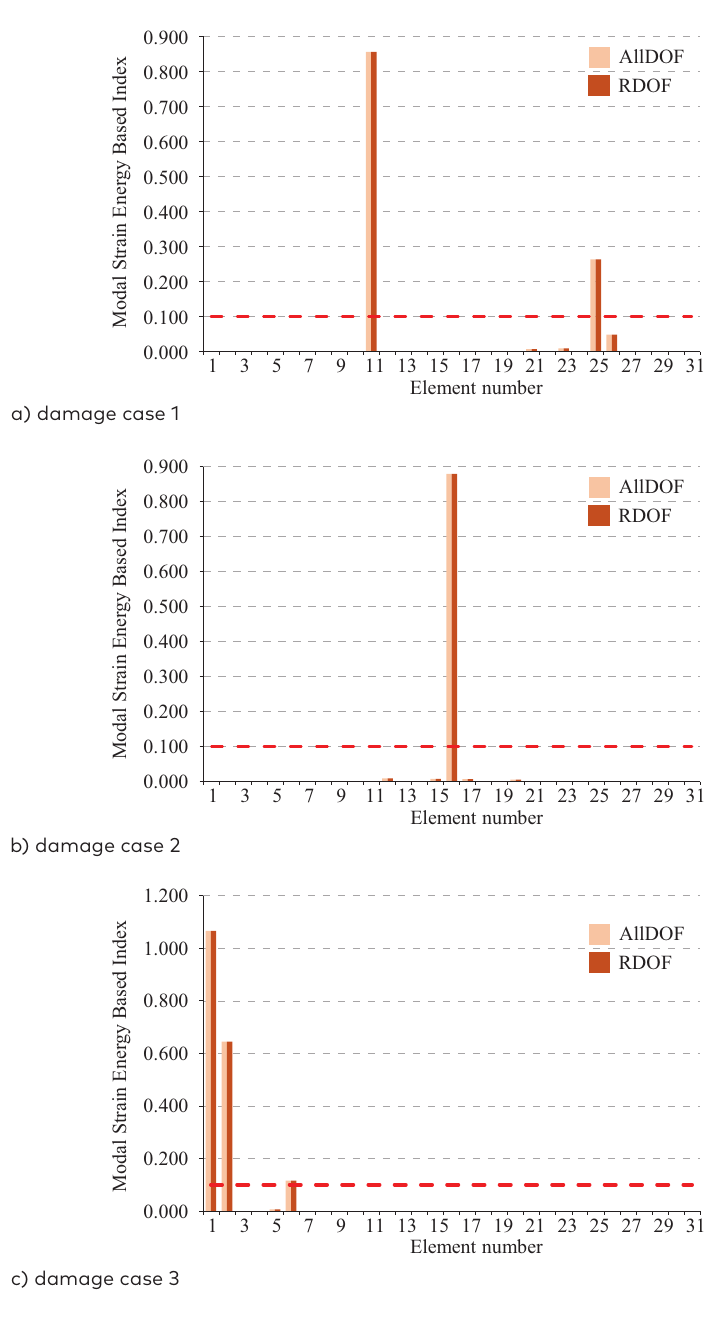
Figure 9. Damage index values in 31-element truss for seven modes without